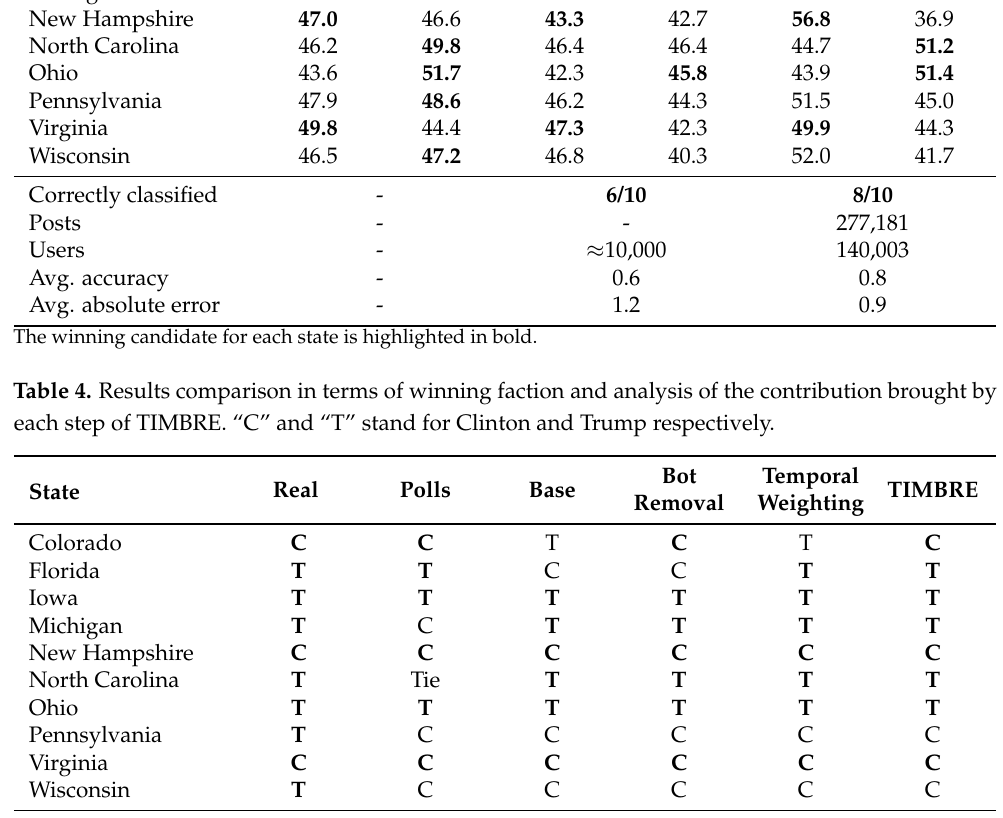
Table 3. Voting percentages estimates of the 2016 US presidential election. State